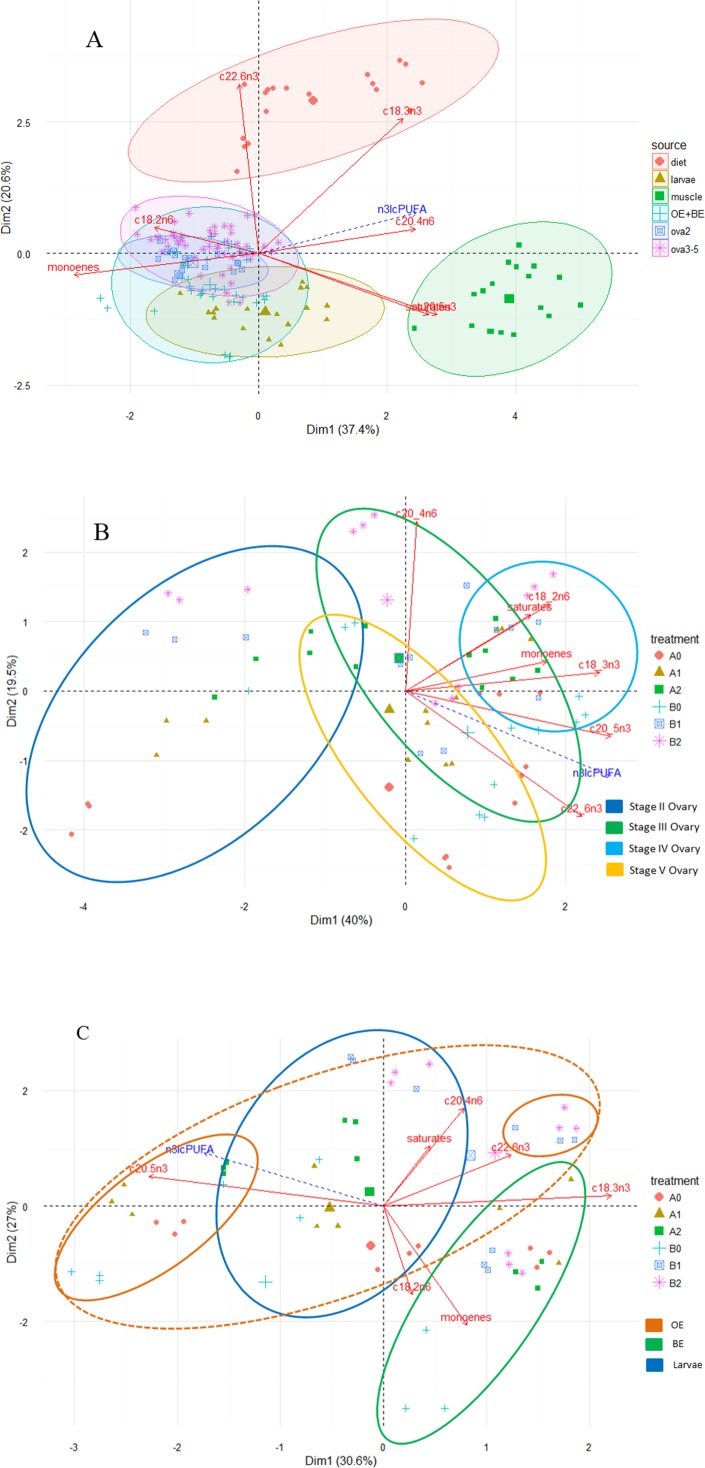
Principal component analysis (PCA) biplot of fatty acid compositions (% of total fatty acid) in diet and tissues of M. rosenbergii.(A) PCA ordination of fatty acid compositions in experimental diets and M. rosenbergii tissues, muscle, reproductive tissues and larvae. (B) Among-treatment variation of fatty acid compositions in ovaries II–V and (C) in eggs and larvae. OE is newly fertilized, orange eggs of M. rosenbergii and BE is mid-stage embryo, brown eggs. Each oval outline color represents a tissue type.